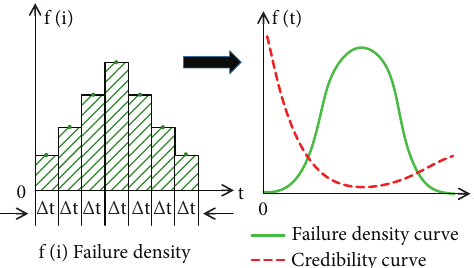
Figure 3: Variation diagram of function, failure curve, and reli- ability